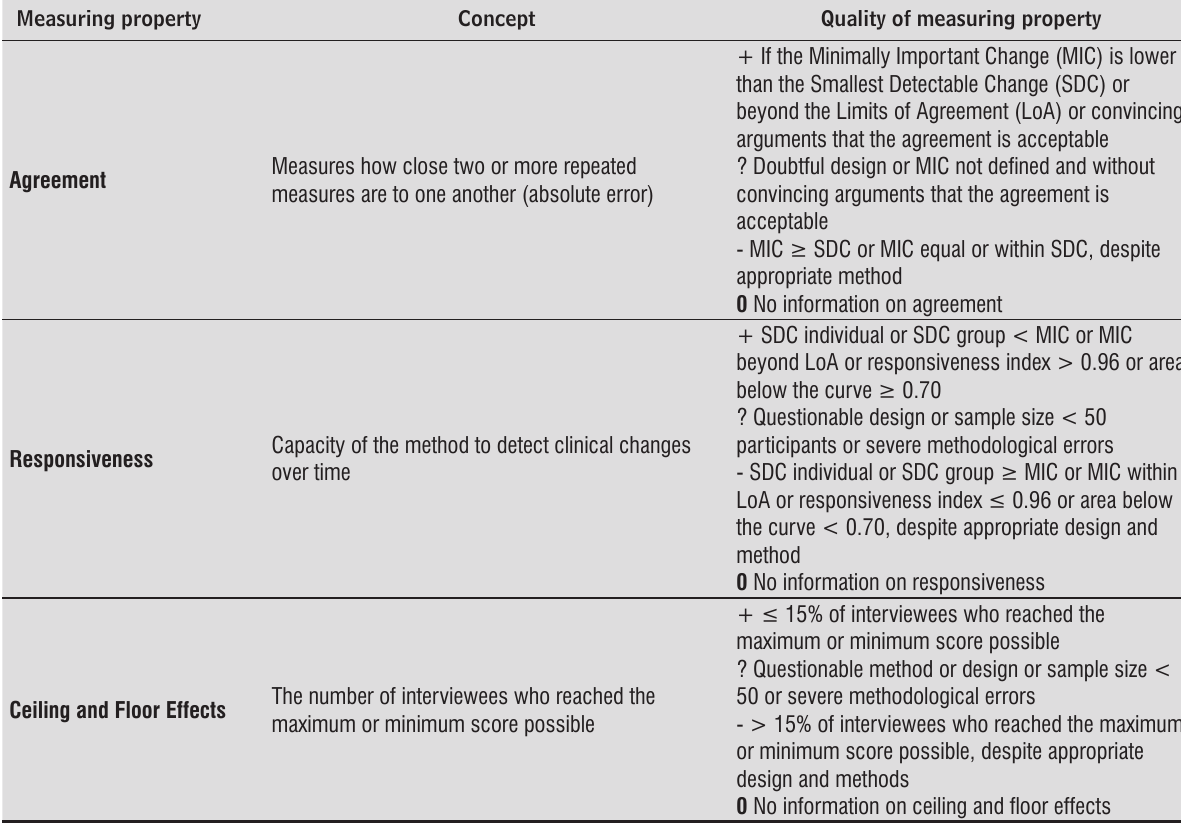
Table 2 - Quality Criteria for Measuring Properties of Questionnaires in Health (11, 12, 13)